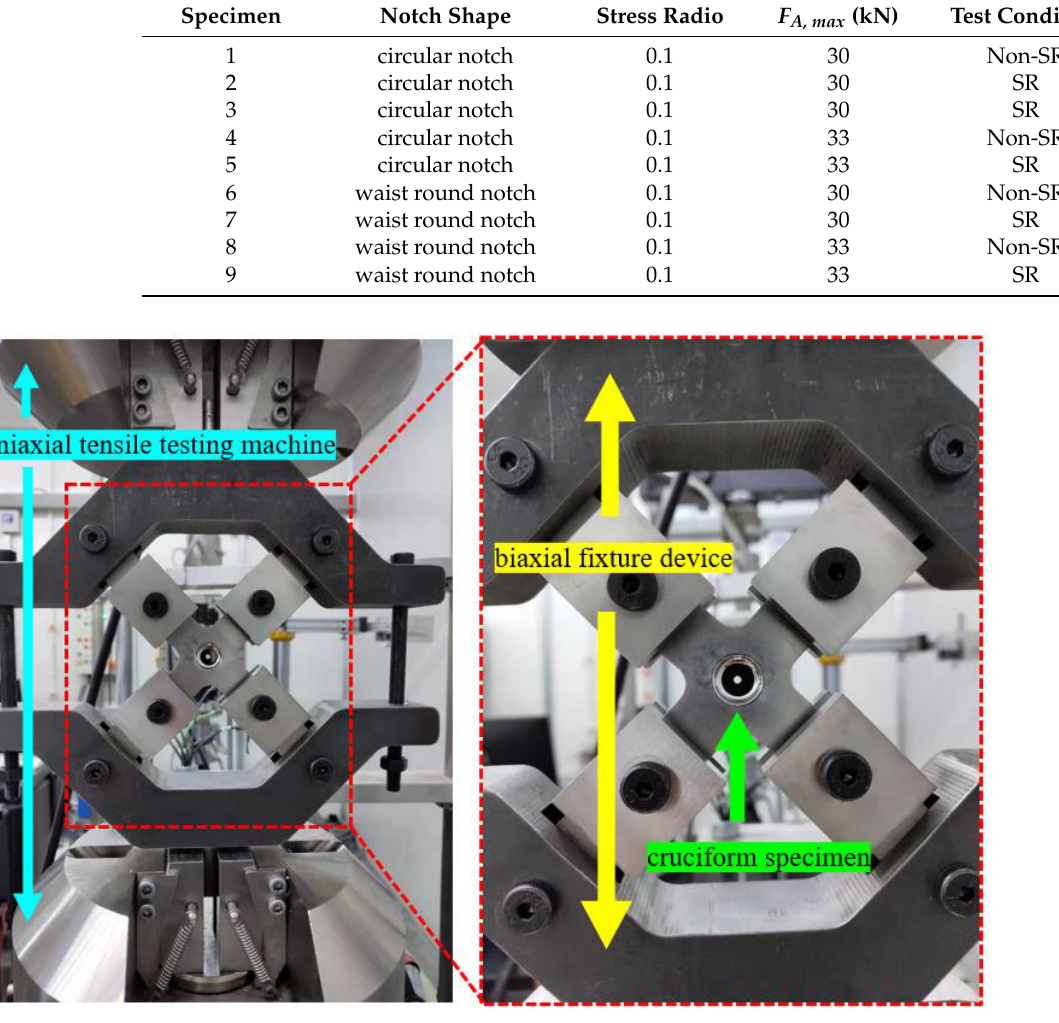
Figure 3. Biaxial fatigue test device.